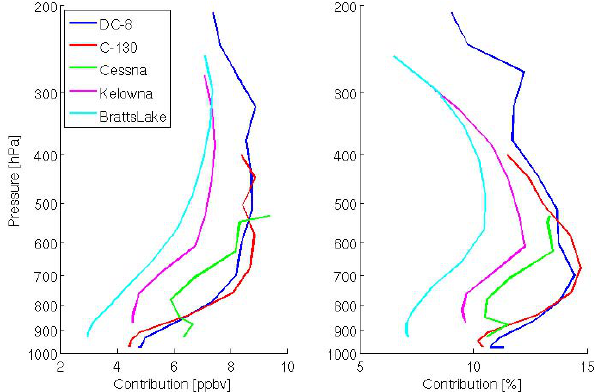
Fig. 10. Vertical profiles of the mean difference between baseline and “no Asia” simulations at the locations of the three aircraft and two ozonesonde